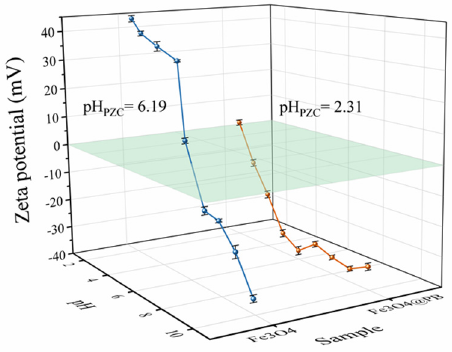
Figure 3. Zeta potential of the Fe 3 O 4 and Fe 3 O 4 @PB as a function of pH.